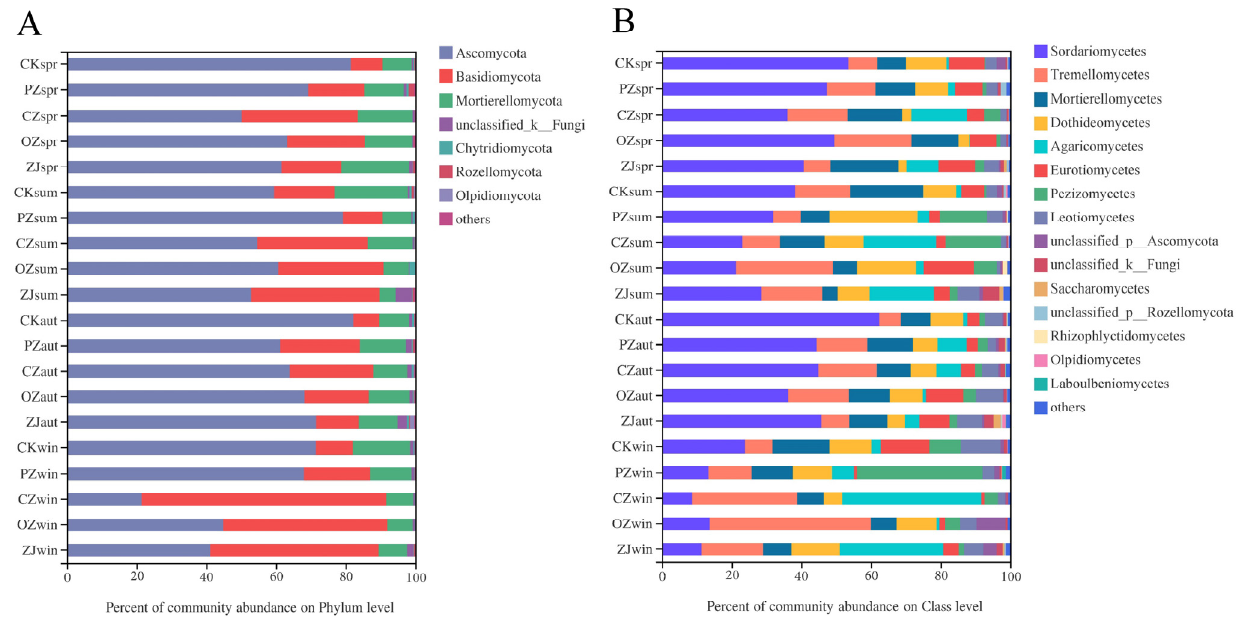
Figure 3. Relative abundances of soil fungal community structure at phylum ( A ) and class ( B ) levels. CK: control; PZ: C . heterophylla ; CZ: C . kweichowensis ; OZ: C . avellane ; ZJ: C . heterophylla × C . avellane ; spr: spring; sum: summer; aut: autumn; win: winter.